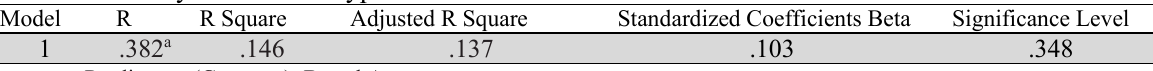
Model Summary for the first hypothesis